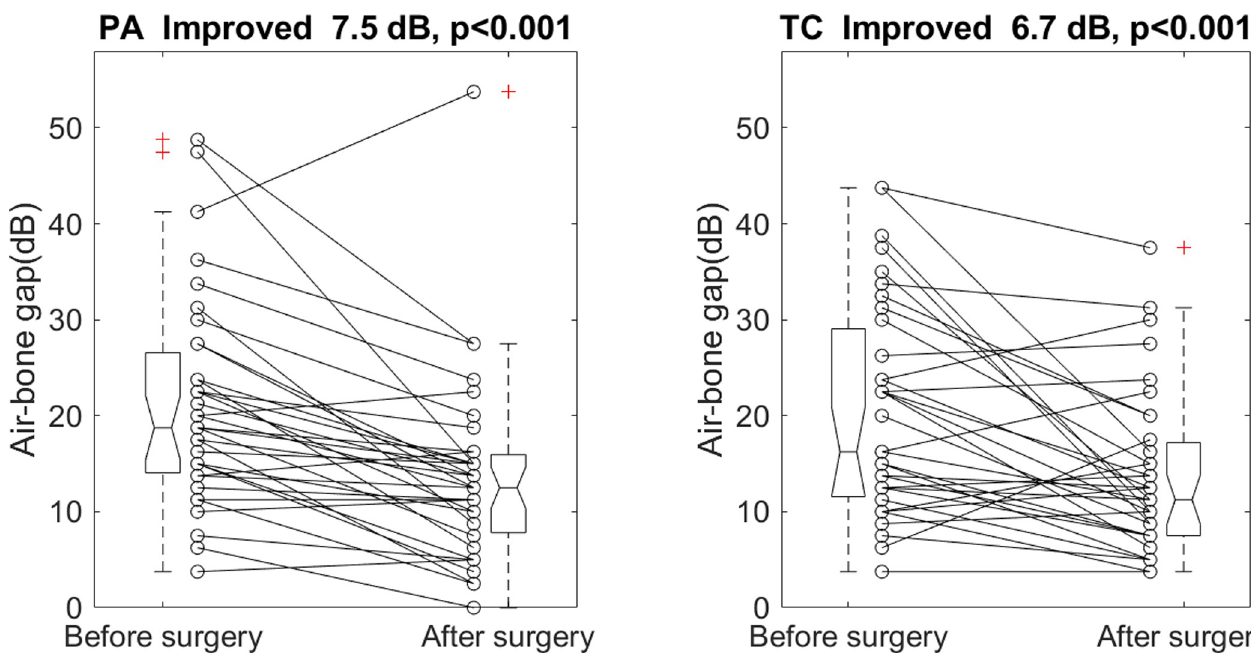
Fig 1. Individual mean air-bone gap of 0.5, 1, 2, and 4k Hz before and after the surgery. PA: Postauricular. TC: Transcanal. +: An outlier. Each boxplot displays a five-number summary: The minimum, the maximum, the median, and the first and third